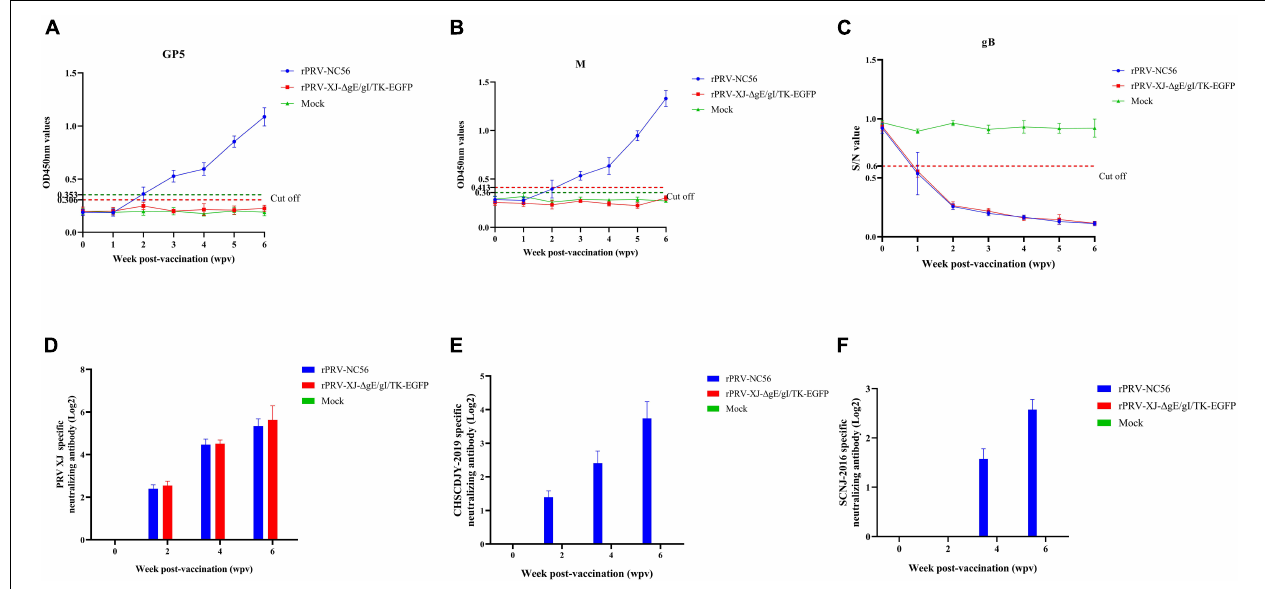
FIGURE 7 | Immune responses after immunization with rPRV-NC56. (A) The GP5-specific antibodies were calculated by ELISA. (B) The M-specific antibodies were calculated by ELISA. (C) The gB-specific antibodies were calculated by ELISA. (D) Detection results of anti-PRV XJ-neutralizing antibody titer in the serum of